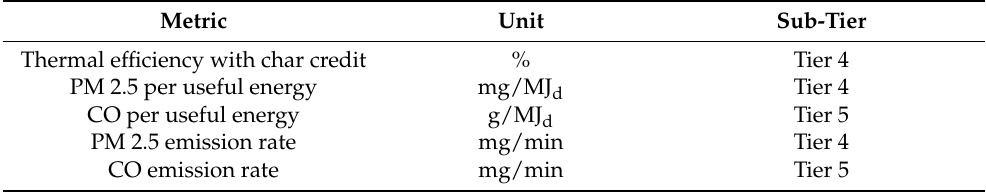
Table 6. Classification of the corresponding parameters according to ISO 19867-3:2018 [20]. Metric Unit Metric